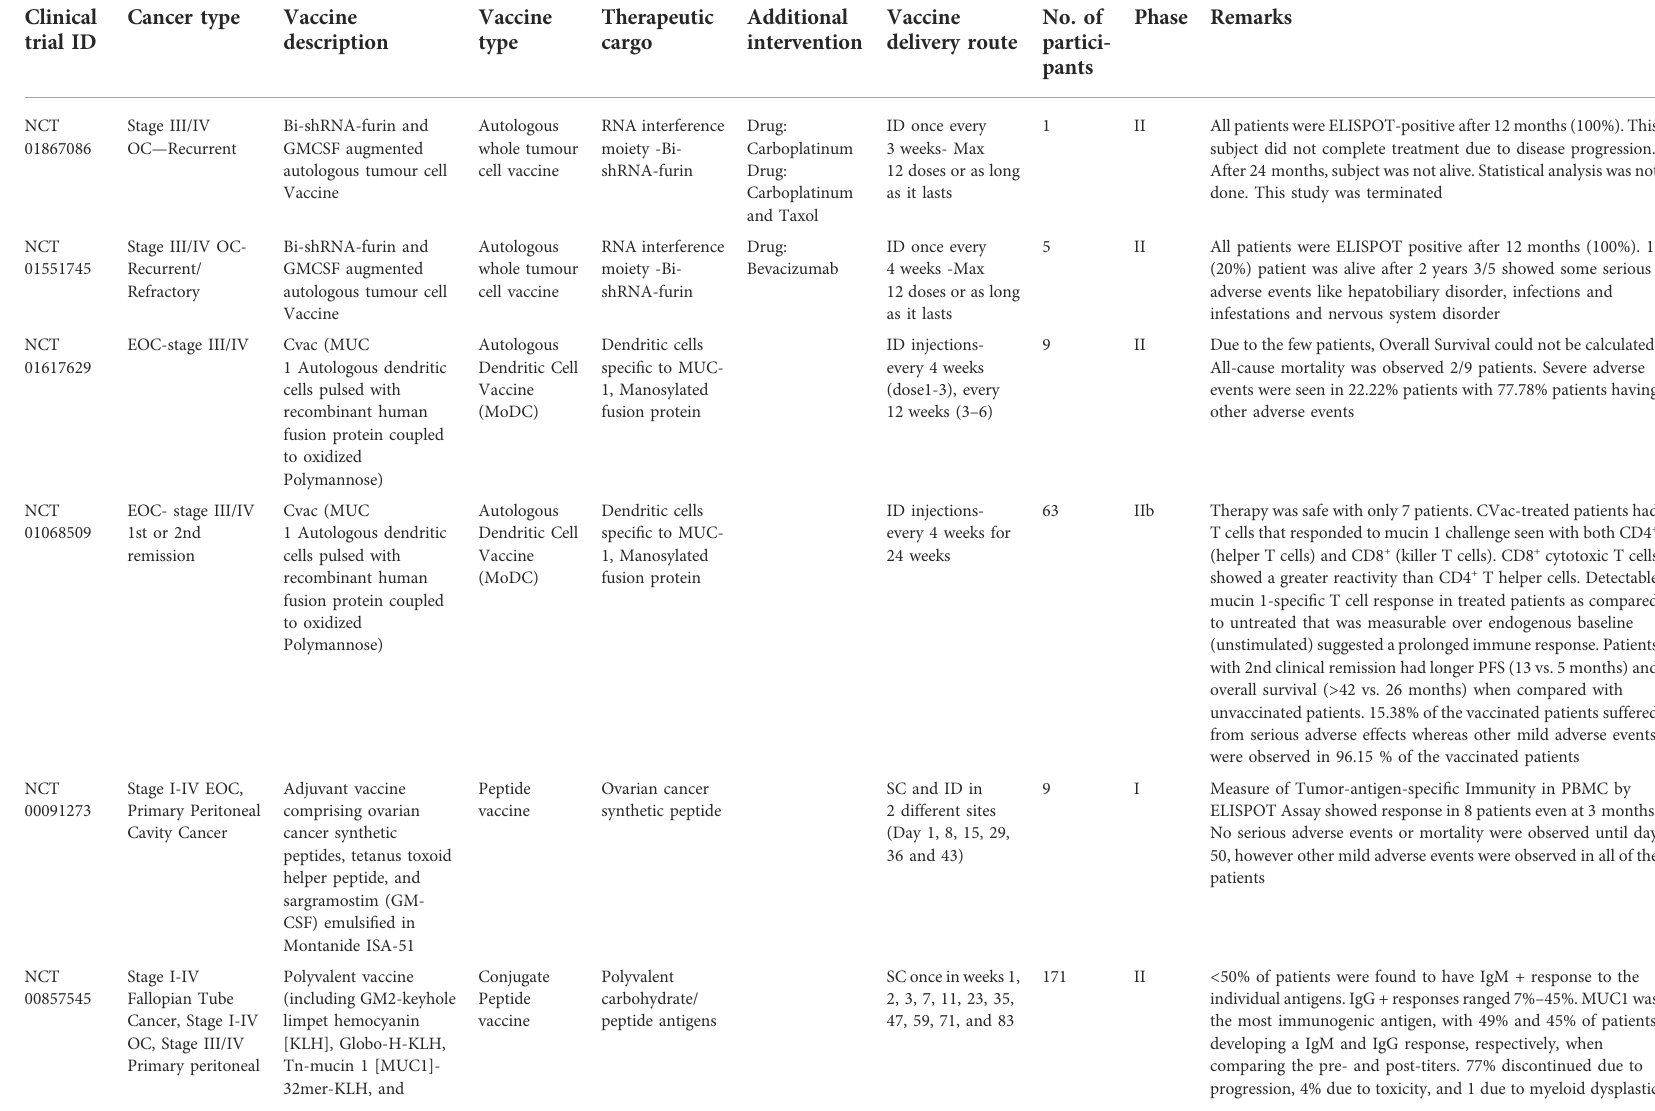
TABLE 2 Table of completed clinical trials showing promising results for various cancer vaccines in OC. All of these vaccines have been used as a second line of treatment after initial cytoreductive debulking of the primary tumours and chemotherapy. Clinical trial